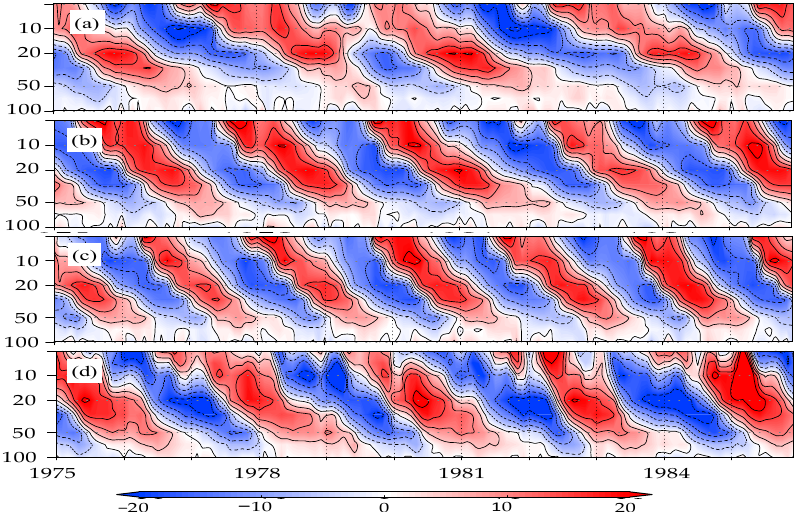
Figure 1. Time–height cross-sections of zonal–mean zonal wind anomalies (ms − 1 ) averaged between 10 ◦ S and 10 ◦ N in the tropical stratosphere (100–5 hPa) for the ( a ) P (+20%), ( b ) ST (0%), and ( c ) N ( − 20%) runs, and ( d ) ERA-40 from 1975 to 1985. Contours interval is 5 ms − 1 .